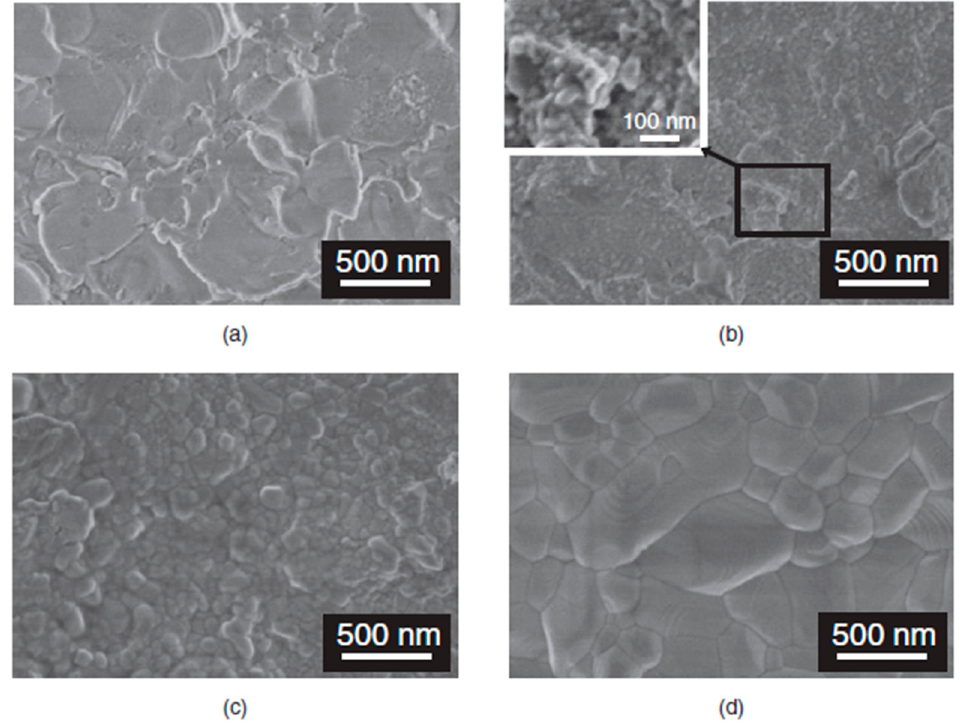
Figure 17. SEM images of SrBi 2 Ta 2 O 9 (SBTa) films deposited on Pt/Ti/yttria-stabilized zirconia (YSZ) ceramic substrates ( a ) as-deposited and annealed at ( b ) 700 °C for 30 min, ( c ) 900 °C for 30 min, and ( d ) 1100 ◦ C for 30 min [49]. © Copyright 2012, Jpn. J. Appl. Phys. Lett.